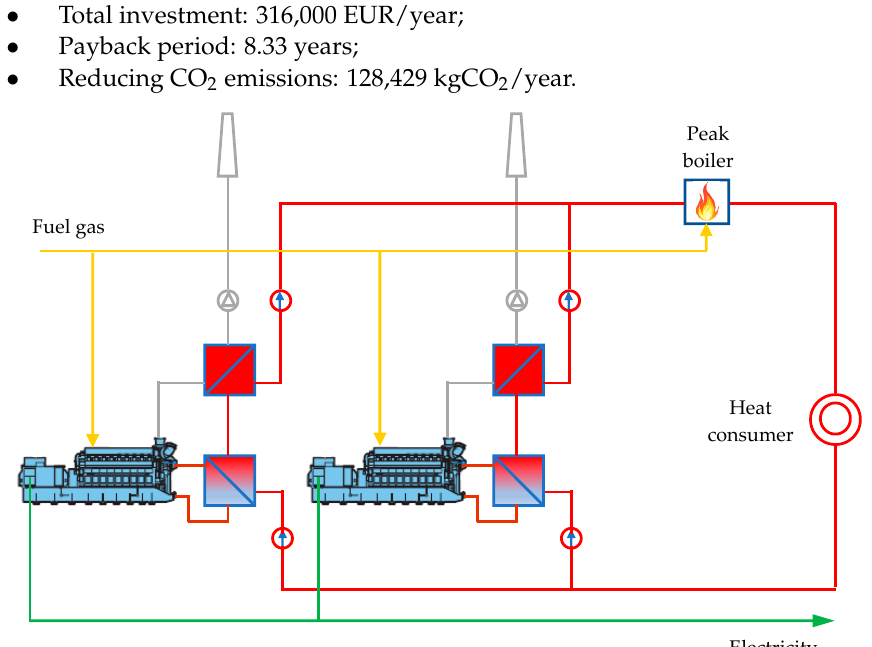
Figure 21. Cogeneration with two units and a peak boiler.